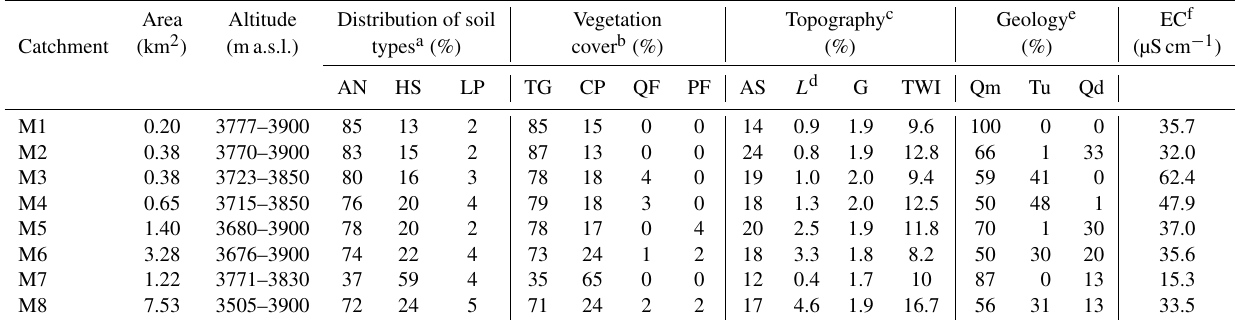
Table 1. Main landscape characteristics of the monitored catchments. Area Altitude Distribution of soil Vegetation Topography c Geology e EC f Catchment (km 2 ) (ma.s.l.) types a (%) cover b